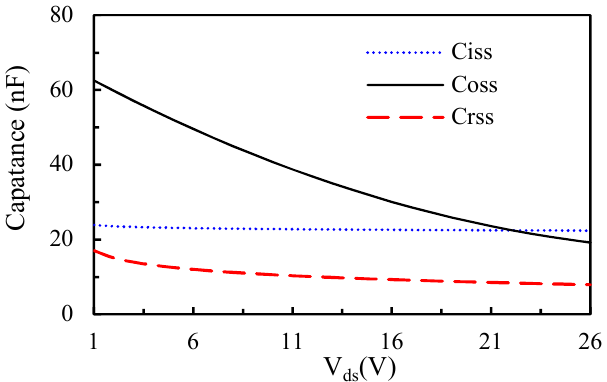
Figure 4. Power MOSFET switching transient: ( a ) turn-on waveform and ( b ) turn-off waveform.